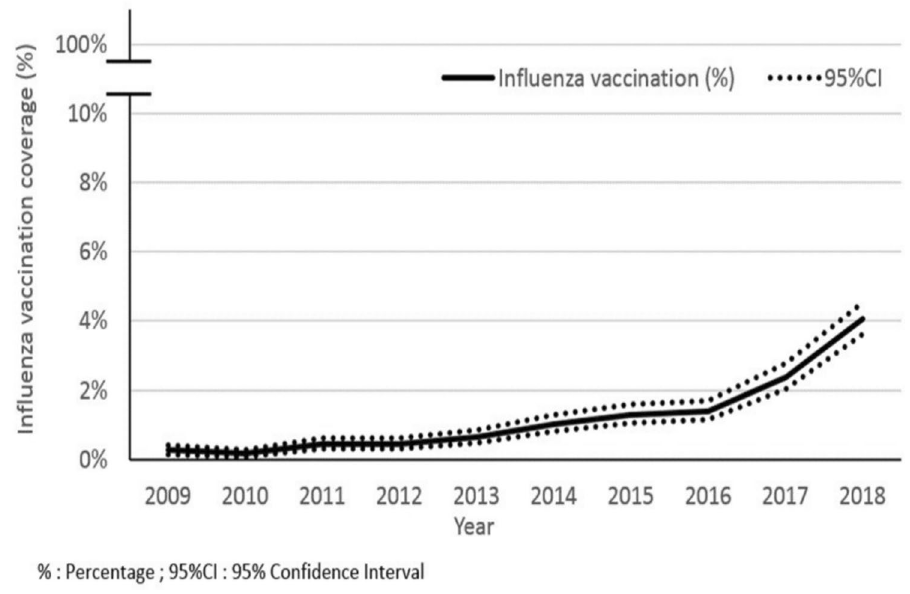
Figure 3. Evolution of the influenza vaccination coverage from 2009 to 2018.